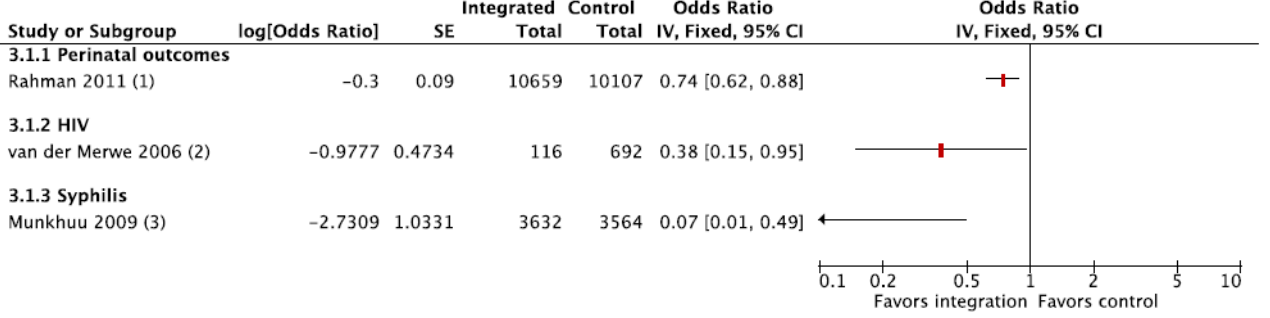
Figure 4. Health outcomes (odds of adverse health outcomes in integrated care vs controls). (1) Perinatal mortality, adjusted; (2) Number of HIV infections among infants born to HIV+ mothers; (3) Number of congenital syphilis cases.